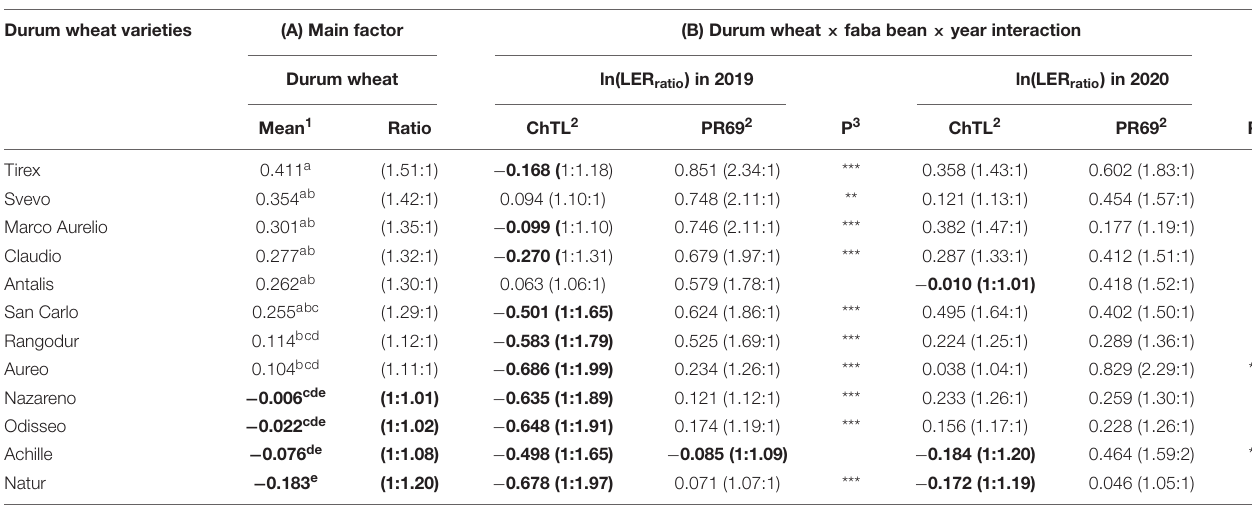
TABLE 4 | ln(LER ratio